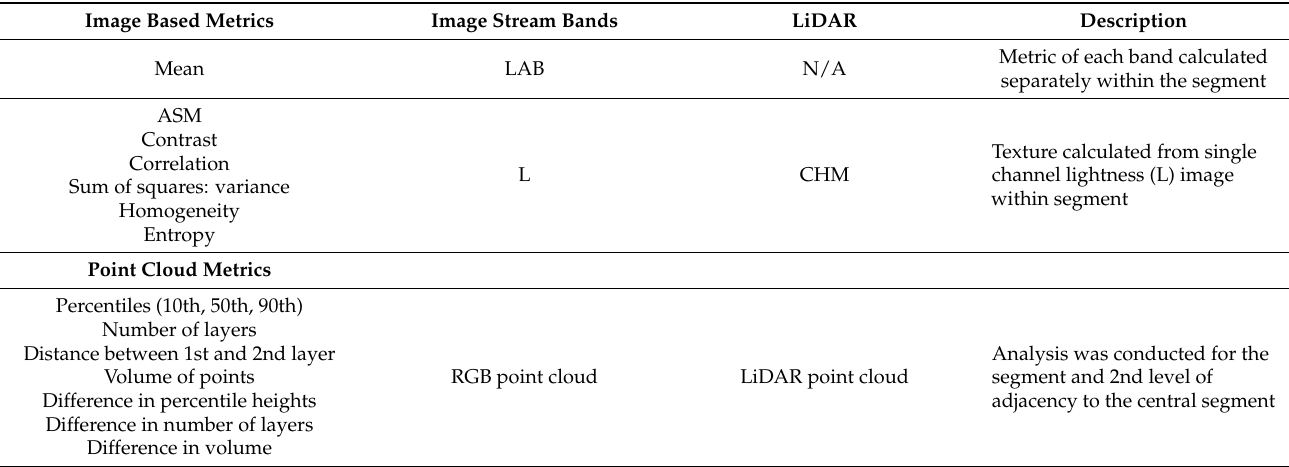
Table 4. Metrics derived from image-based and point cloud products for classification of vegetation and fire severity. Image Based